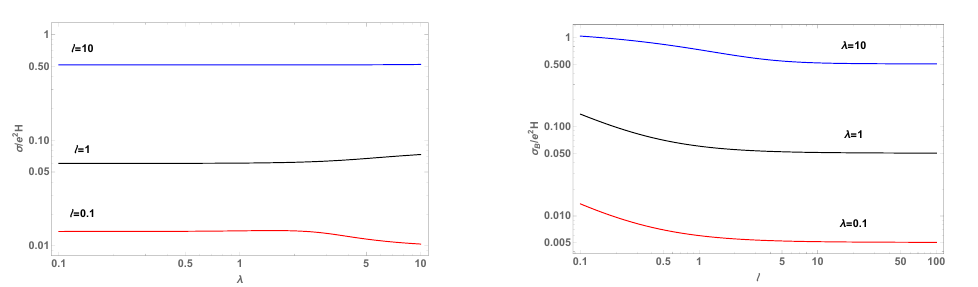
σ / e 2 H B (cid:31) (cid:30)